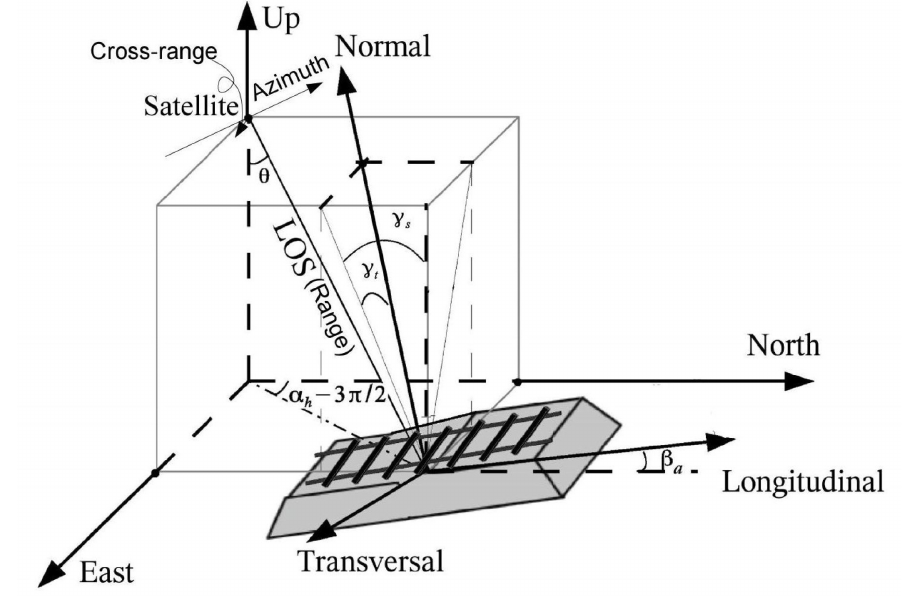
Figure 1. 3D radar (with range, azimuth and cross-range directions), terrestrial reference (with east, north, and up directions), and local rail-track-fixed Cartesian coordinates (with transversal, longitudinal and normal direction). θ , γ s , γ t , α h , and β a separately represent the satellite look angle, longitudinal slope of track, cant of the track, satellite heading angle, and azimuth of the track w.r.t. the north. Adapted from